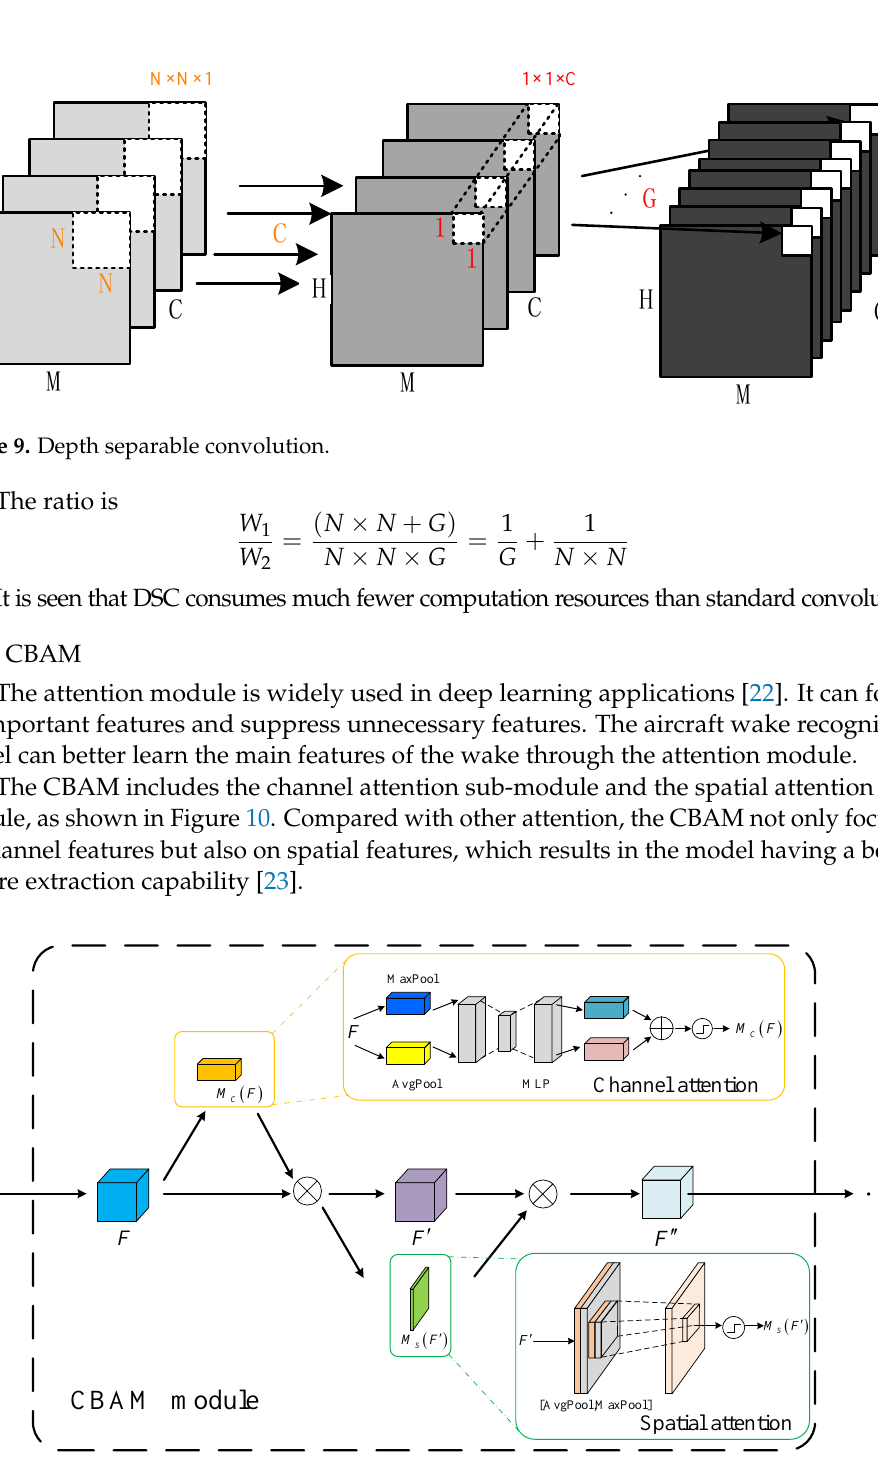
Figure 10. Structure of CBAM.